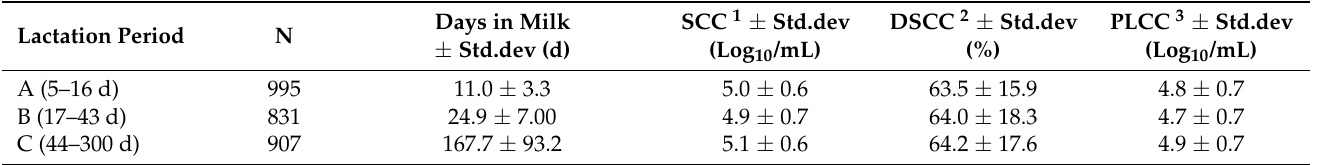
Table 1. Description of sample characteristics: mean values ± standard deviation of cow days in milk and cellular markers within the three lactational periods considered.